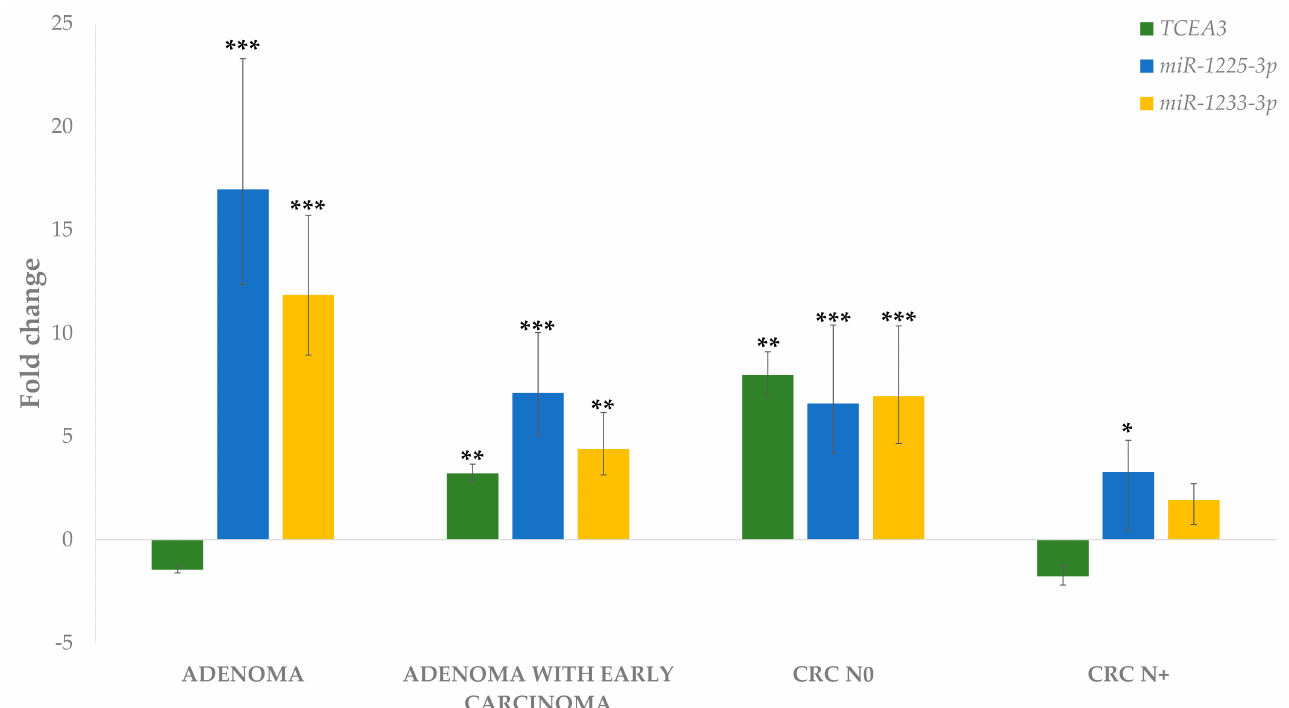
Figure 10. Expression of TCEA3 , miR-1225-3p and miR-1233-3p in adenoma, adenoma with early carcinoma and carcinoma without and with lymph node metastases. Legend: CRC, colorectal carcinoma; N0, without lymph node metastases; N+, with lymph node metastases; * p ≤ 0.05; ** p ≤ 0.01; *** p ≤ 0.001.